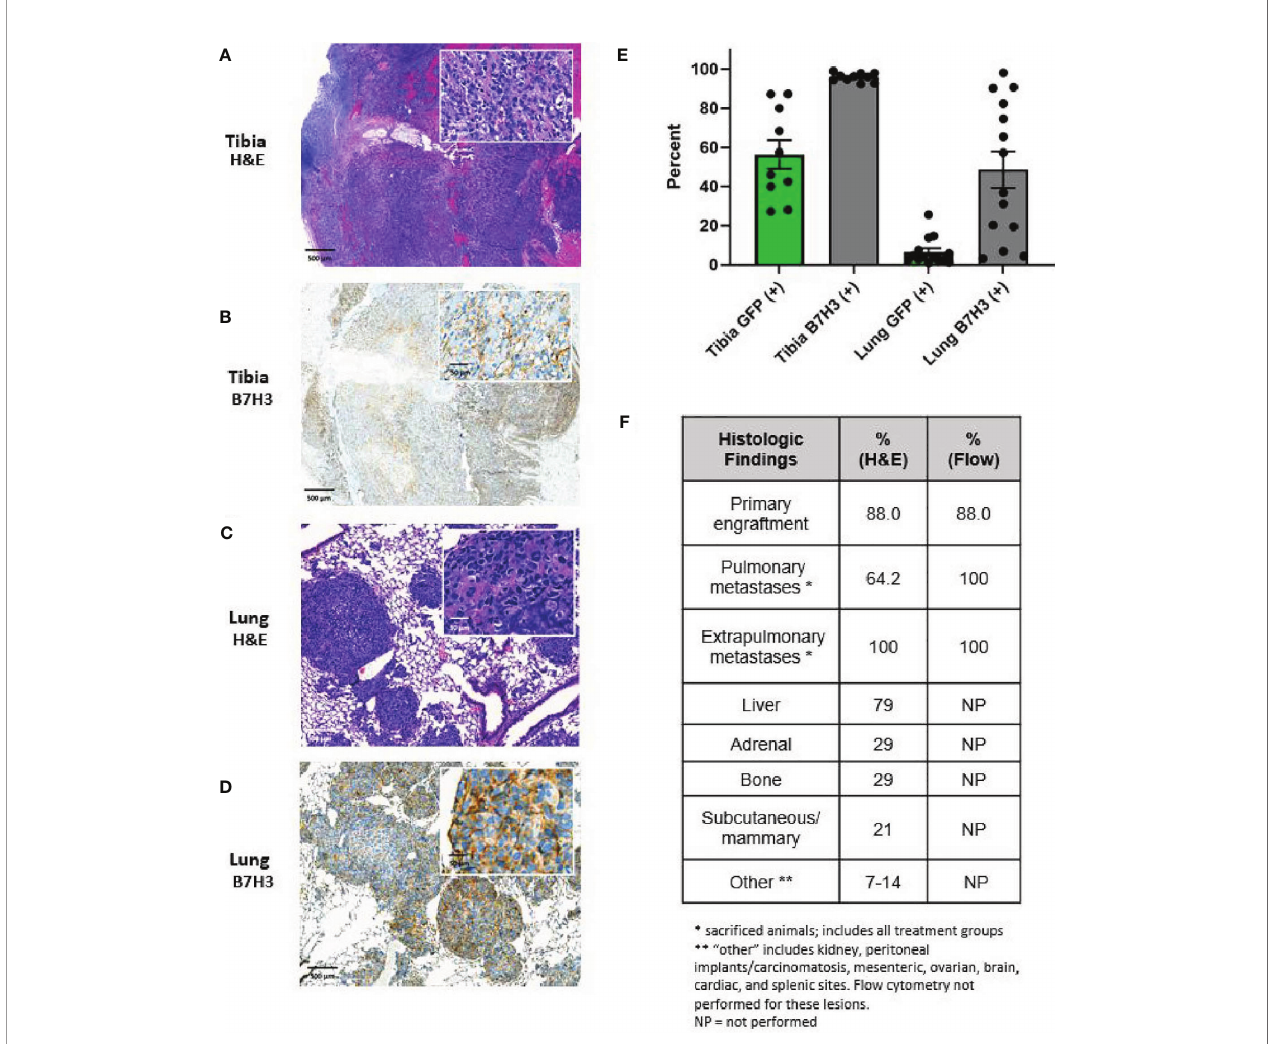
FIGURE 5 | Characterization of primary and metastatic lesions. Primary tibial osteosarcoma lesions are characterized by (A) H&E and B) B7H3 immunohistochemical staining, demonstrating formation of lesions with the appearance of malignant osteoid and invasion of the cortex and marrow cavity as well as B7H3 expression. Pulmonary metastases are characterized by (C) H&E and (D) B7-H3 immunohistochemical staining, demonstrating consistency of metastatic lesions with osteosarcoma lesions and persistent B7-H3 after metastasis. For (A – D) , scale indicated is 500 m m for low power images and 50 m m for high power inserts. (E) Percent of tumor cells (GFP+) and B7-H3 expression on tumor cells (B7-H3+) as assessed by fl ow cytometry. Primary tumor sites contained high percentages of human tumor cells as assessed by GFP fl uorescence (mean 56.5%, SE 7.3%). Tumor cells were additionally detected in all right lungs of mice not achieving long-term survival (mean 6.6%, SE 1.9%). B7-H3 expression was additionally demonstrated in all primary lesions (mean 95.8%, SE 2.2%) and pulmonary metastatic lesions (mean 48.7%, SE 9.4%). (F) Percent of animals with primary site engraftment, pulmonary metastases, and other distant